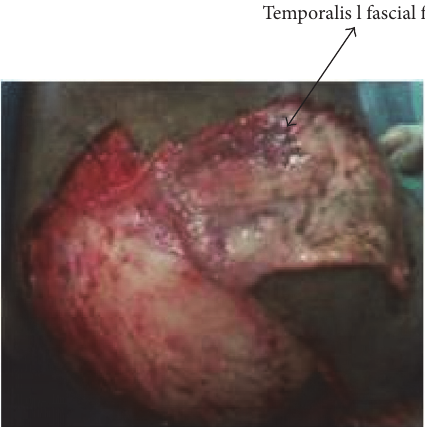
Figure 1: Scalp defect after excision of the tumour.